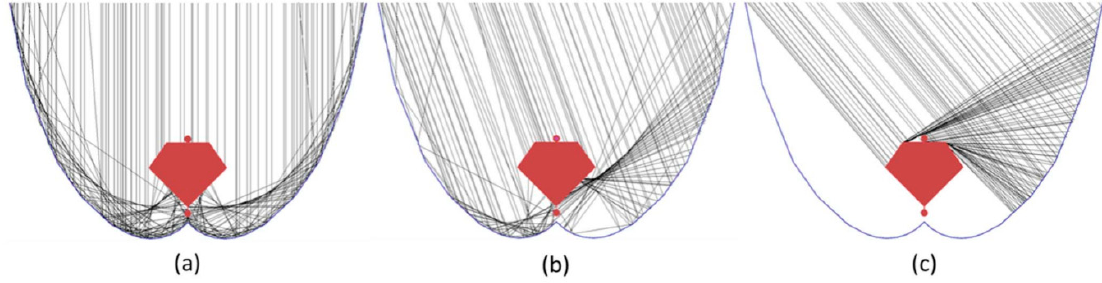
Figure 23. Ray-trace analysis of 40° E/W collector with pentagon absorber for ( a ) normal, ( b ) 20°, and ( c ) 40° incidence [53].